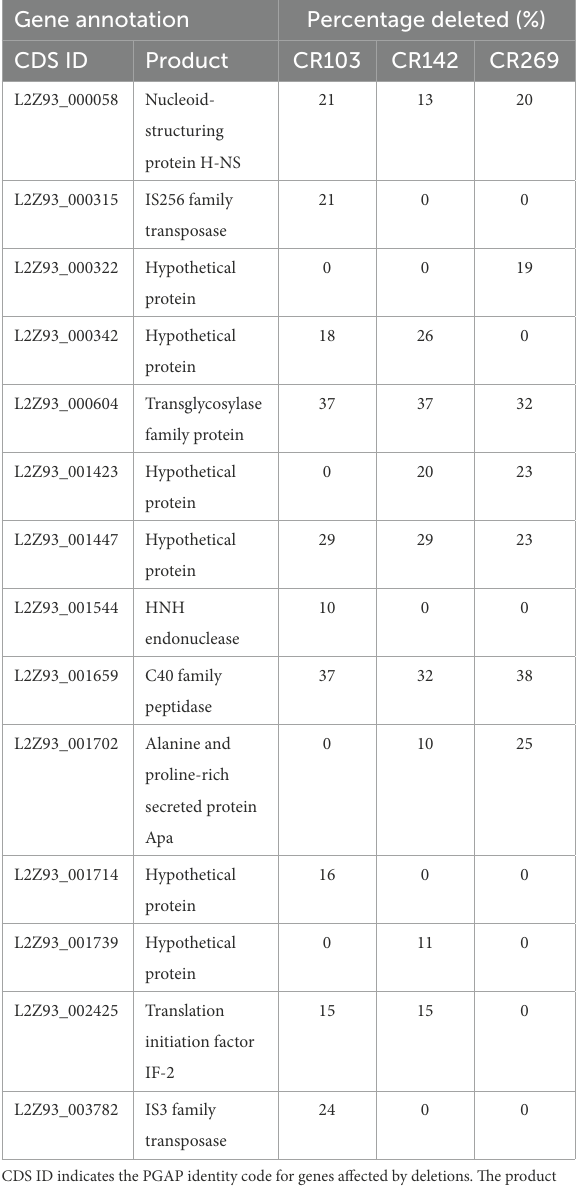
TABLE 4 Genes affected by deletions in the different M . brumae strains compared to the M . brumae reference genome. Gene